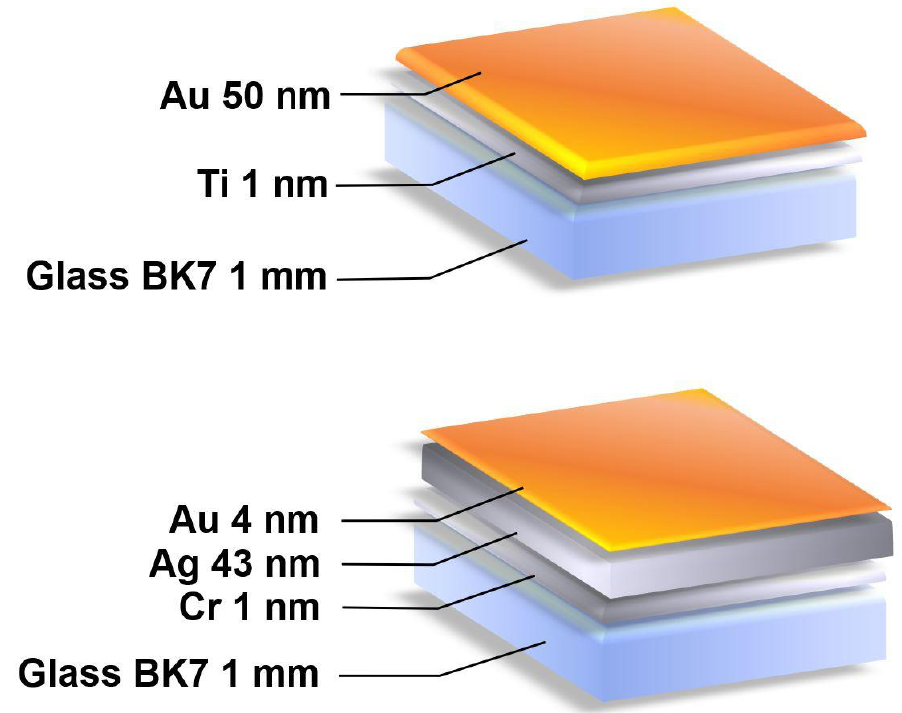
Figure 4. Structure of Ag/Au chip substrate (lower picture) as compared with Au substrate (upper picture).